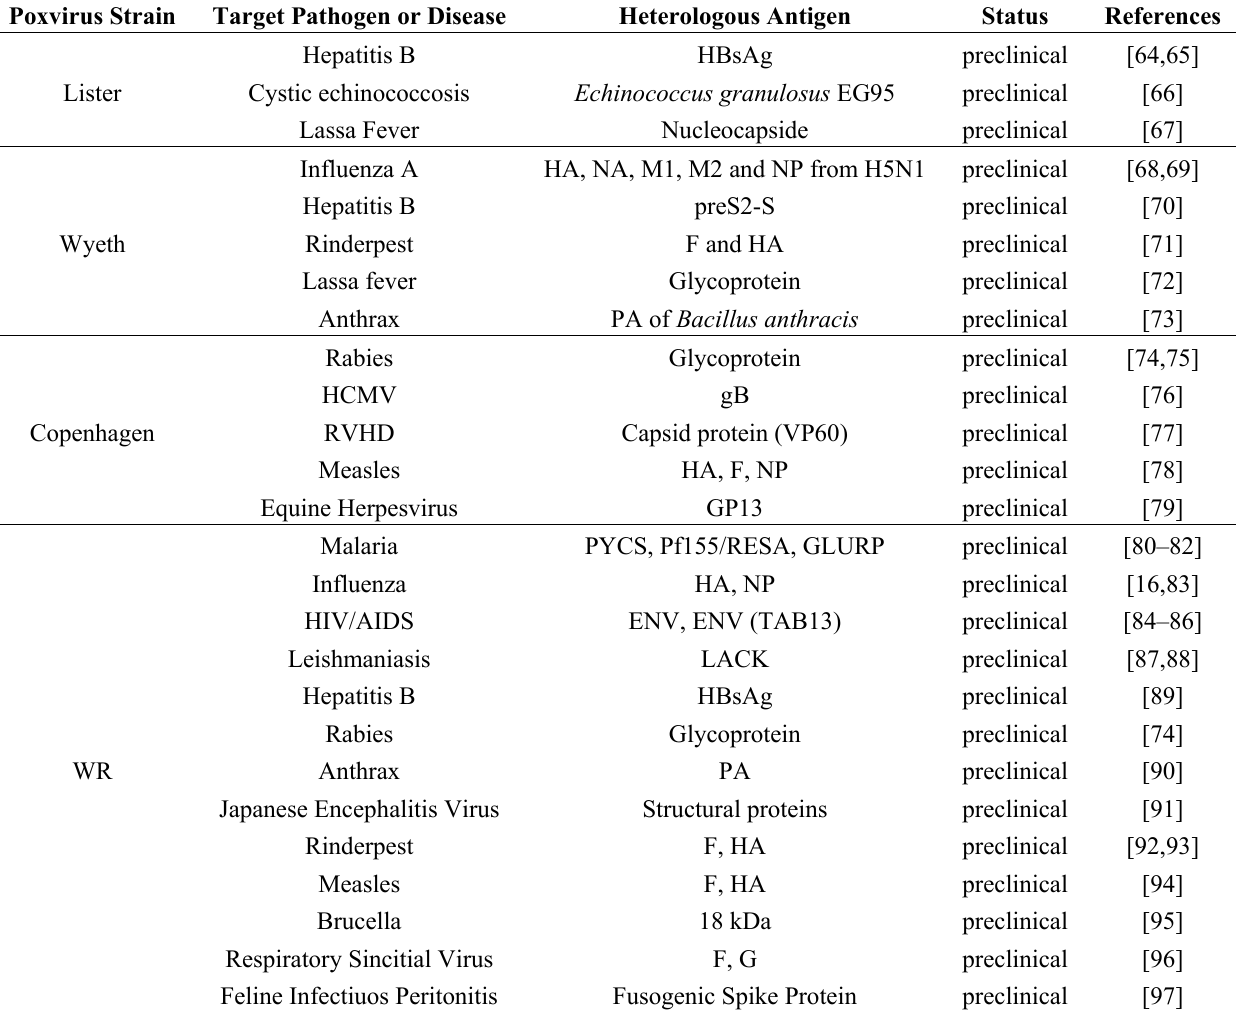
Table 3. Preclinical studies using first- and second-generation poxvirus strains as vaccine candidates against different viral, bacterial and parasitic infectious